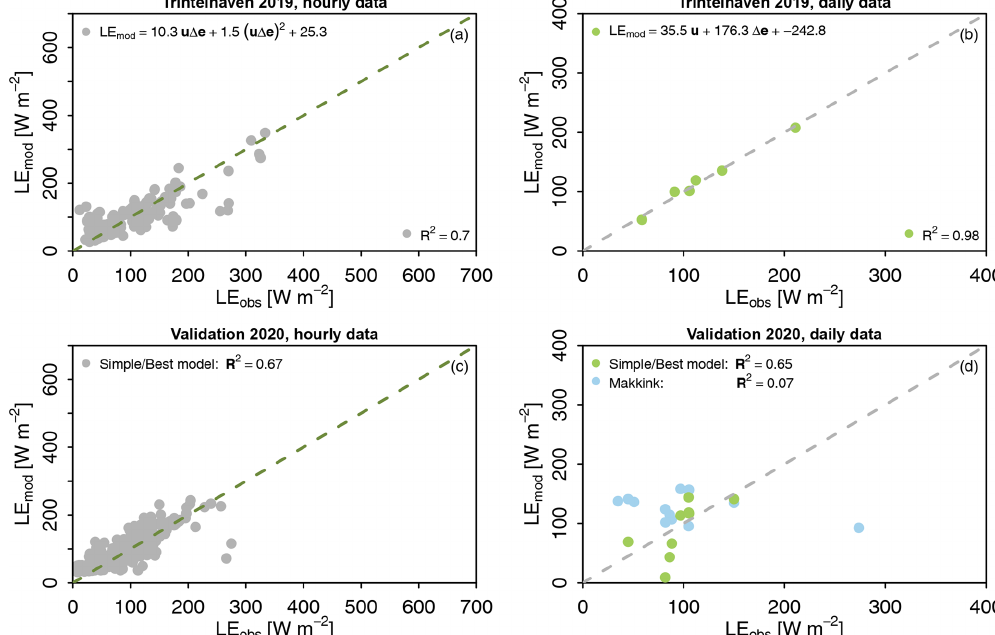
Figure 7. Evaluation of the developed “simple” and “best” data-driven models based on our own observations during the summer of 2019 (cal- ibration) and 2020 (validation) to estimate open water evaporation in Trintelhaven at hourly (a) and daily (b) timescales. The simple model was found to be the best model and is shown using light coloured dots. The model equations are shown in panels (a) and (b) and differ from the models found based on routinely measured observations (see Table 2b). The results of the validation of the models are presented in panels (c) and (d) for hourly and daily timescales respectively. The results of estimated evaporation using Makkink’s model (light blue) are added to the validation plots as a reference. Model performance is indicated by the values of the coefficient of determination ( R 2 ) shown in each panel.